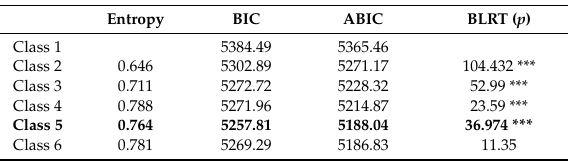
Table 2. Fit indices for latent profile models including Machiavellianism, psychopathy, and narcissism as class